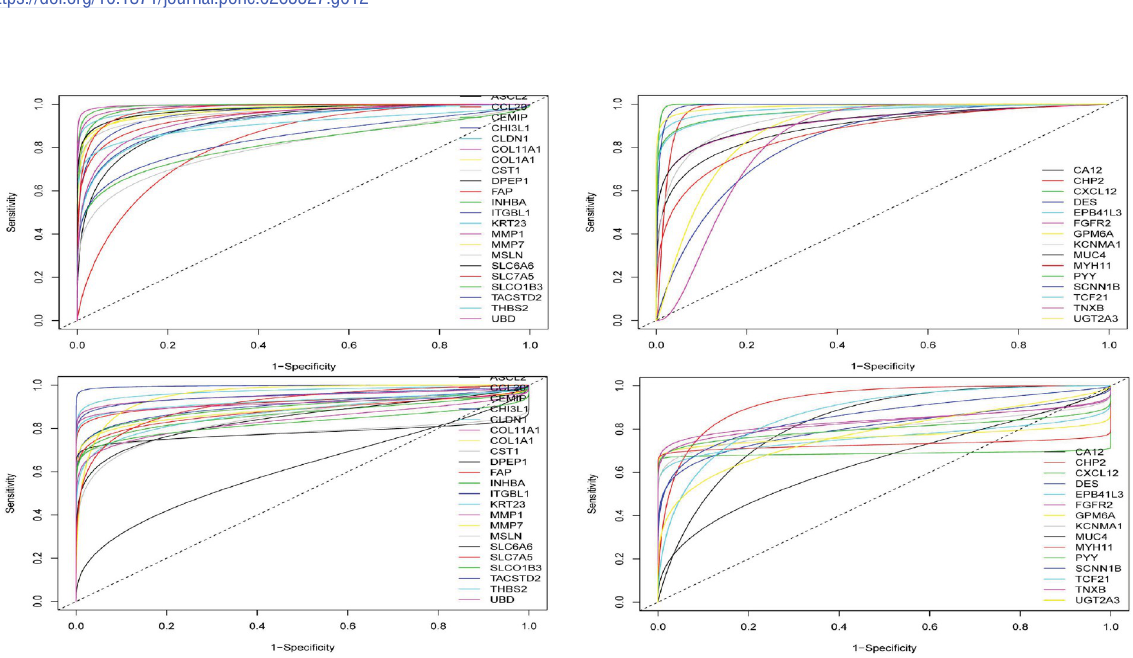
Fig 12. ROC curves for novel validated Differentially Expressed Genes-Differentially Methylated Genes (vDEGs-DMGs). The top curves relate to expression and the bottom curves pertain to methylation.